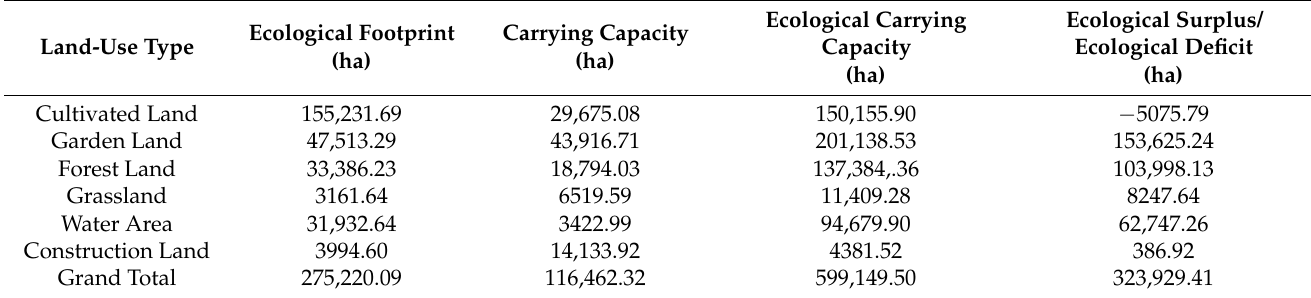
Table 11. Ecological carrying capacity and its state.